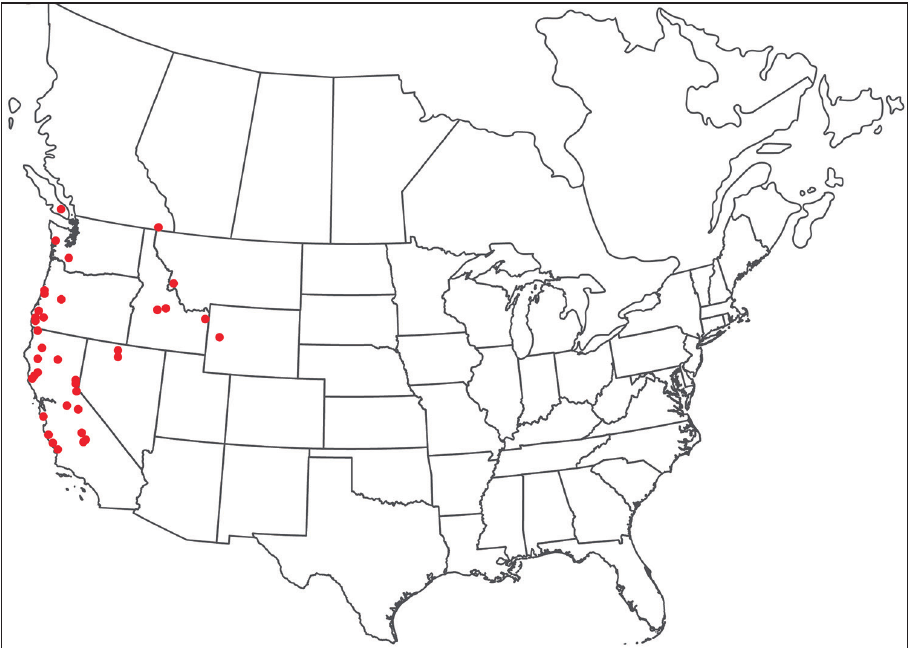
Figure 240. Torrenticola sierrensis